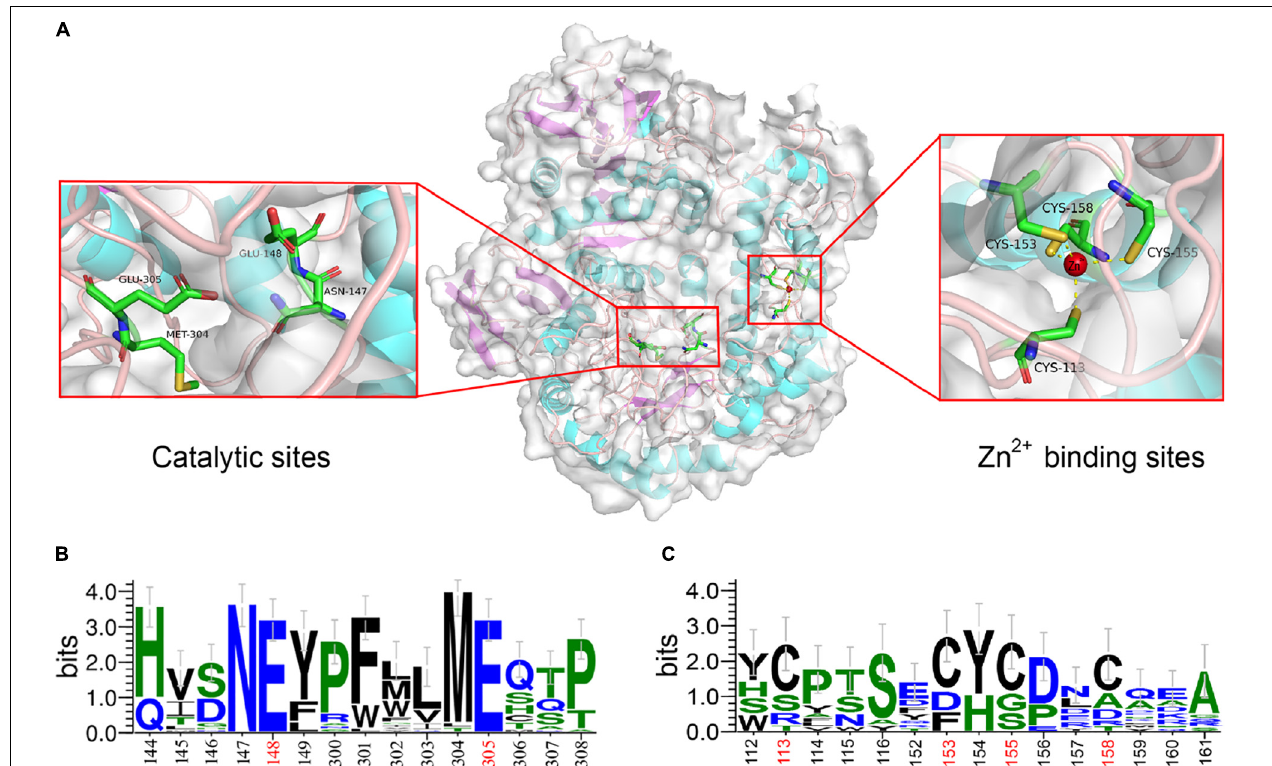
FIGURE 2 | Sequence logo analysis and homology modeling of Gal42. (A) The key residues for substrate specificities in Gal42 are shown as dots mode. (B) Sequence logo analysis of Gal42 catalytic sites. (C) Sequence logo analysis of Gal42 metal binding